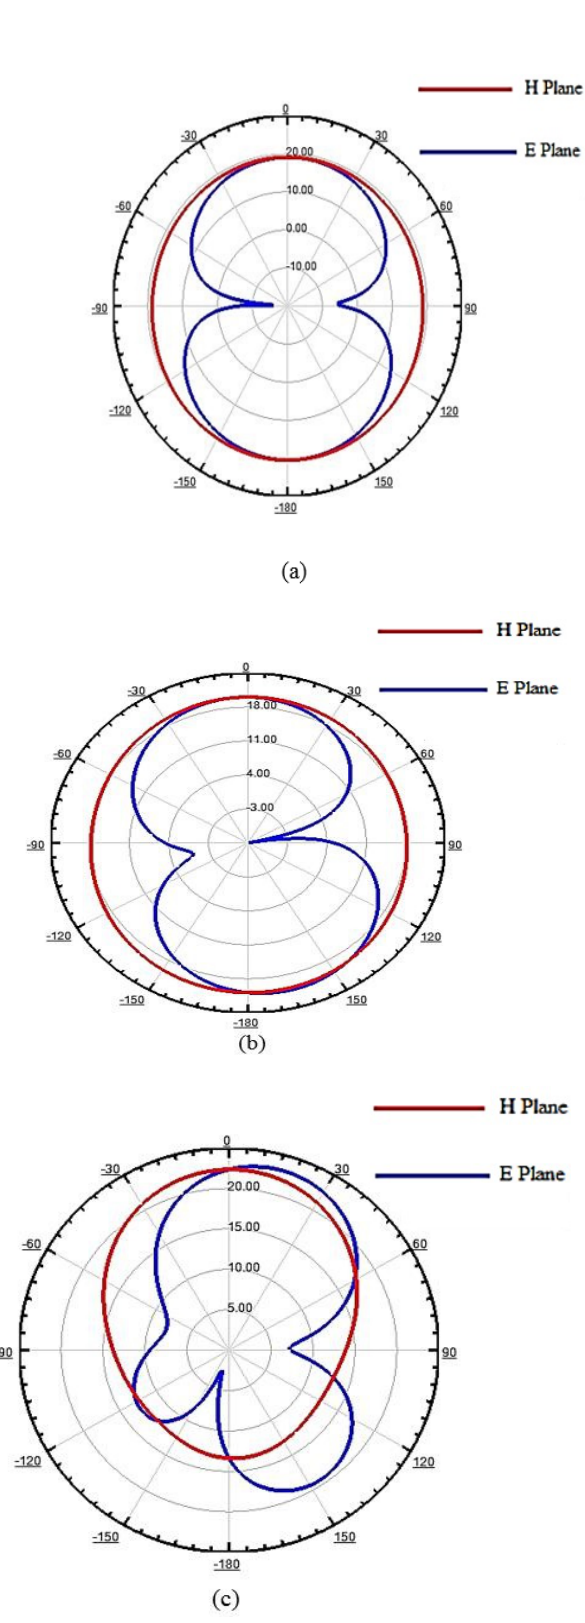
Figure 10: Simulated 2D Radiation Patteren at resonant frequncies of (a)5.5GHz ,(b)8.3 GHz, and (c) 10.7GHz